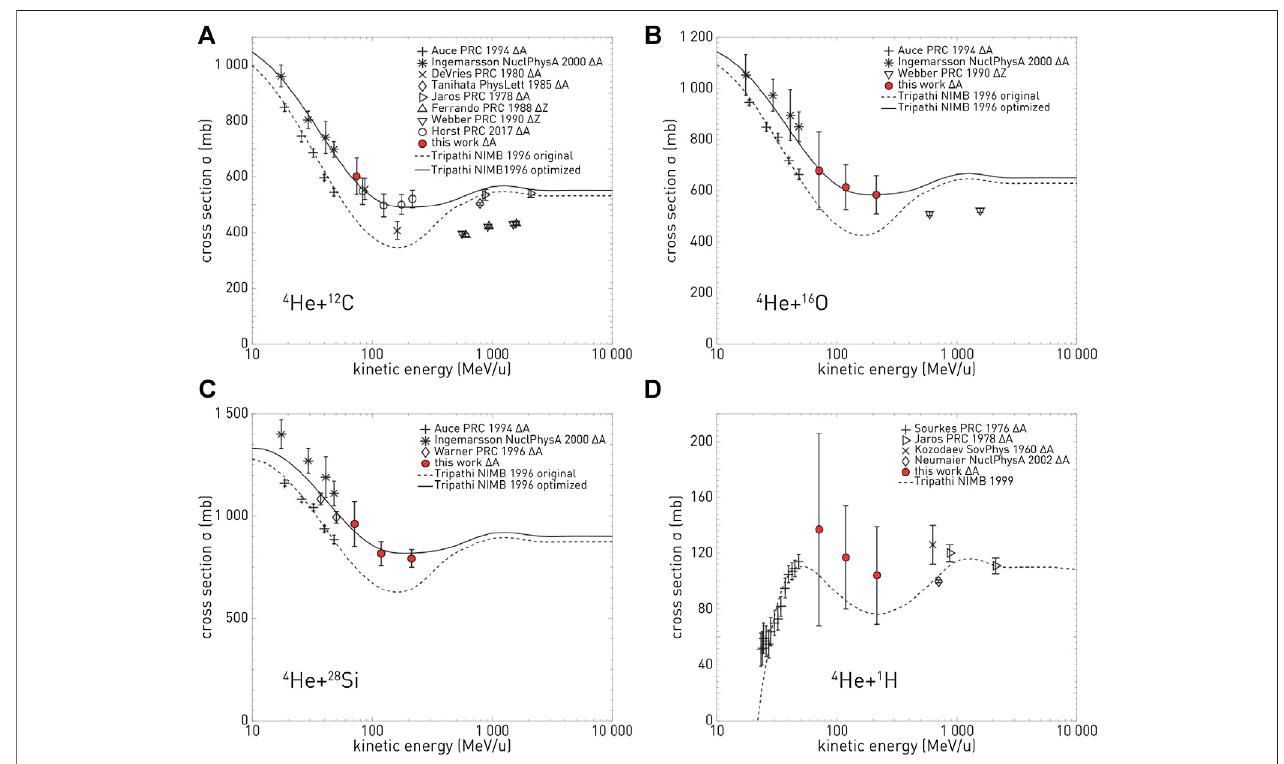
FIGURE2| CrosssectionmeasurementsfromHorstetal.[99]:inred,thenewmeasuredmass-changingcrosssectionsfor 4 HeionsonC (topleft) ,O (topright) , Si (bottom left) , and H (bottom right) targets, compared with different data from the literature and with two parameterizations of the